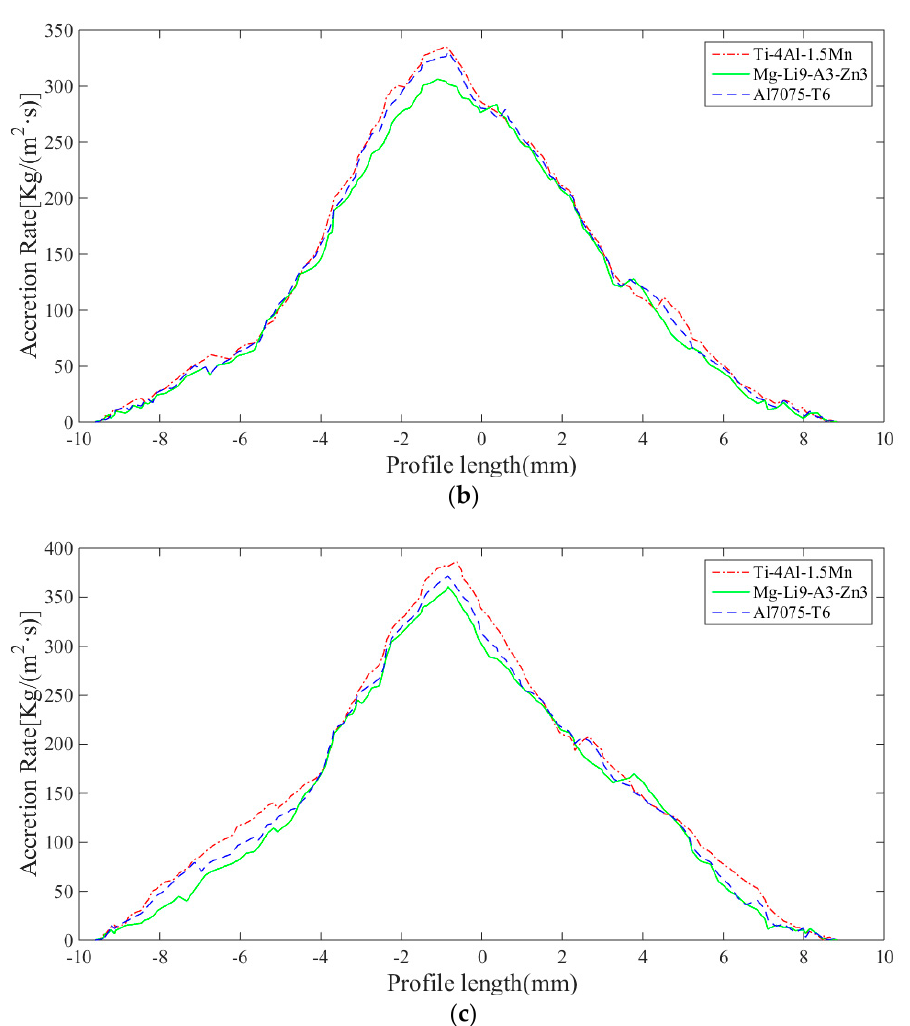
Figure 8. Accretion rate curves of three materials at different impact speeds at 0° angle of attack: ( a ) V P = 70 m/s; ( b ) V P = 150 m/s; ( c ) V P = 220 m/s. Table 6. Average accretion rates of the three material at different impact speeds.